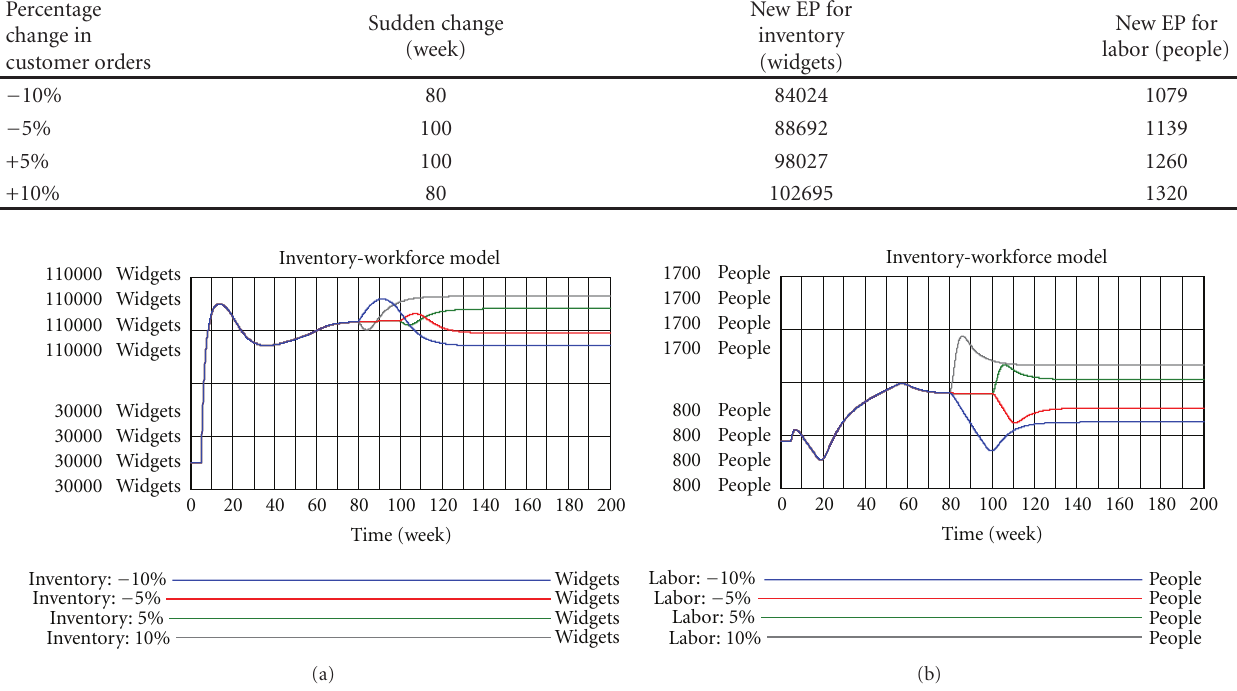
Figure 7: Behavior of state variables after a sudden change in customer